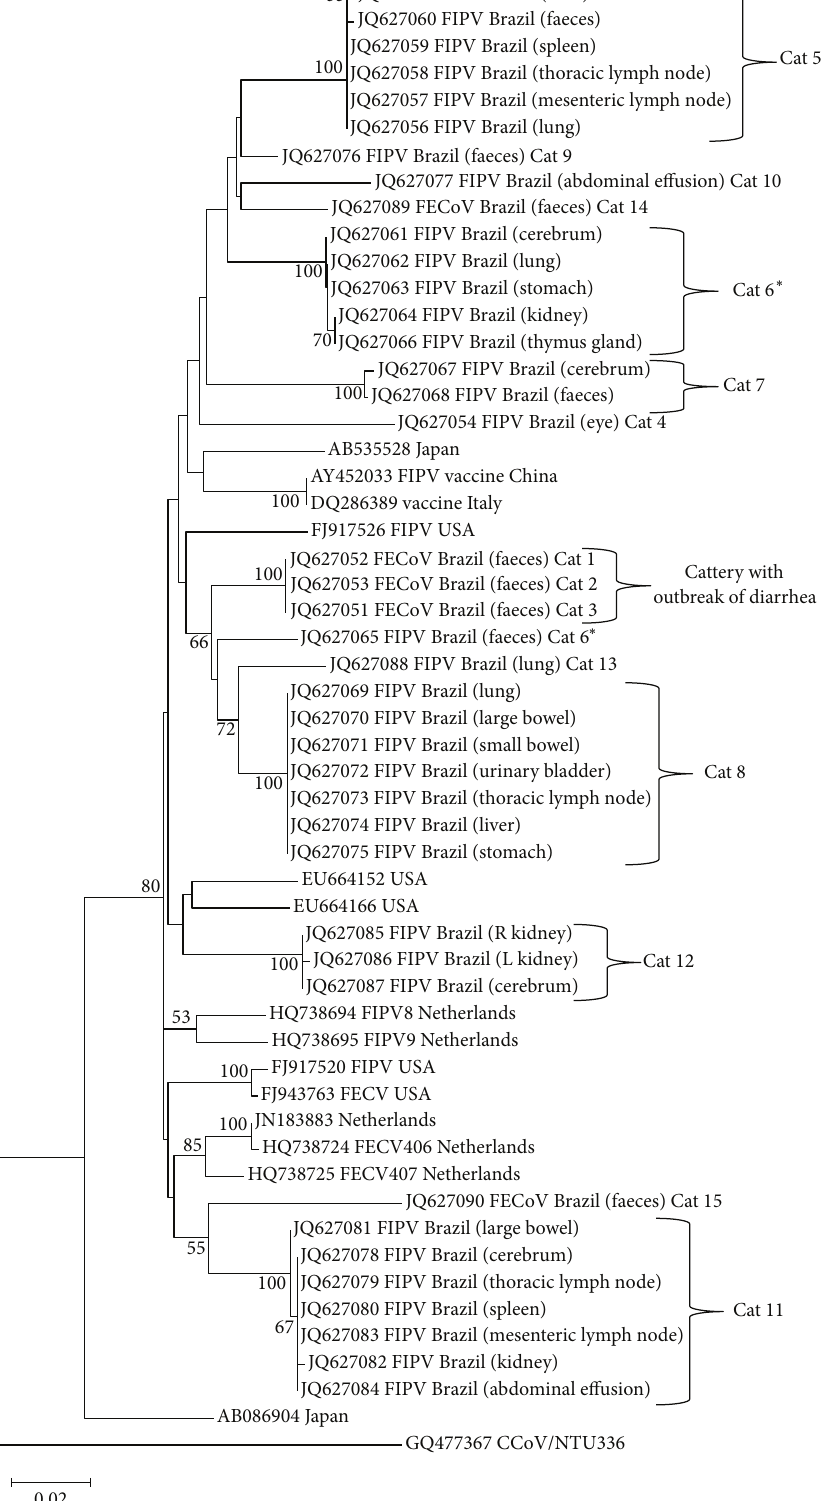
Figure 1: Neighbour-joining MCL phylogenetic tree of the M gene partial sequences of FCoV (positions from 26293 to 26907 regarding strain FCoV UU47). The tree was constructed using a canine coronavirus sequence as an outgroup (GQ477367). Numbers on the nodes indicate the bootstrap support from 1,000 replications. Only bootstrap values > 50 are shown. The scale bar represents the number of substitutions per nucleotide. The numbers from 1 to 15 identify each